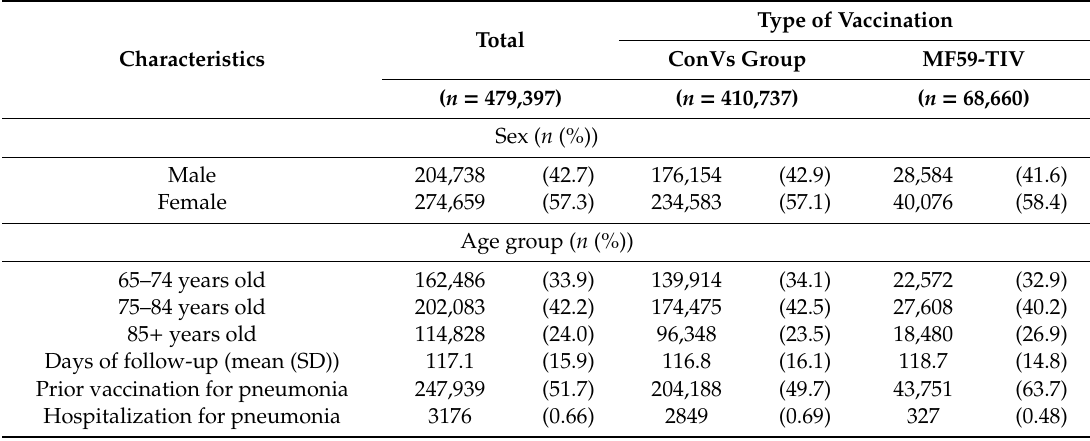
Table 3. Characteristics of individuals in the Friuli Venezia Giulia region vaccinated with either a conventional vaccine or MF59 ‐ TIV in six consecutive flu seasons (2011/2012–2016/2017).